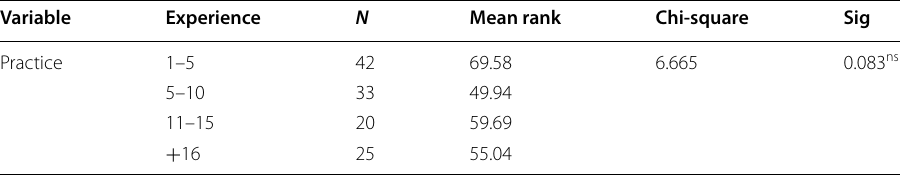
Table 9 Kruskal‑Wallis test for teaching experience and assessment practice